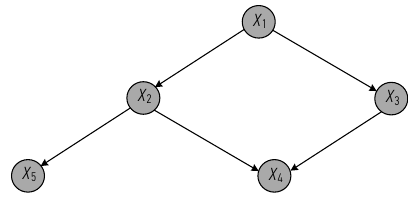
Fig. 1. A sample BN with five